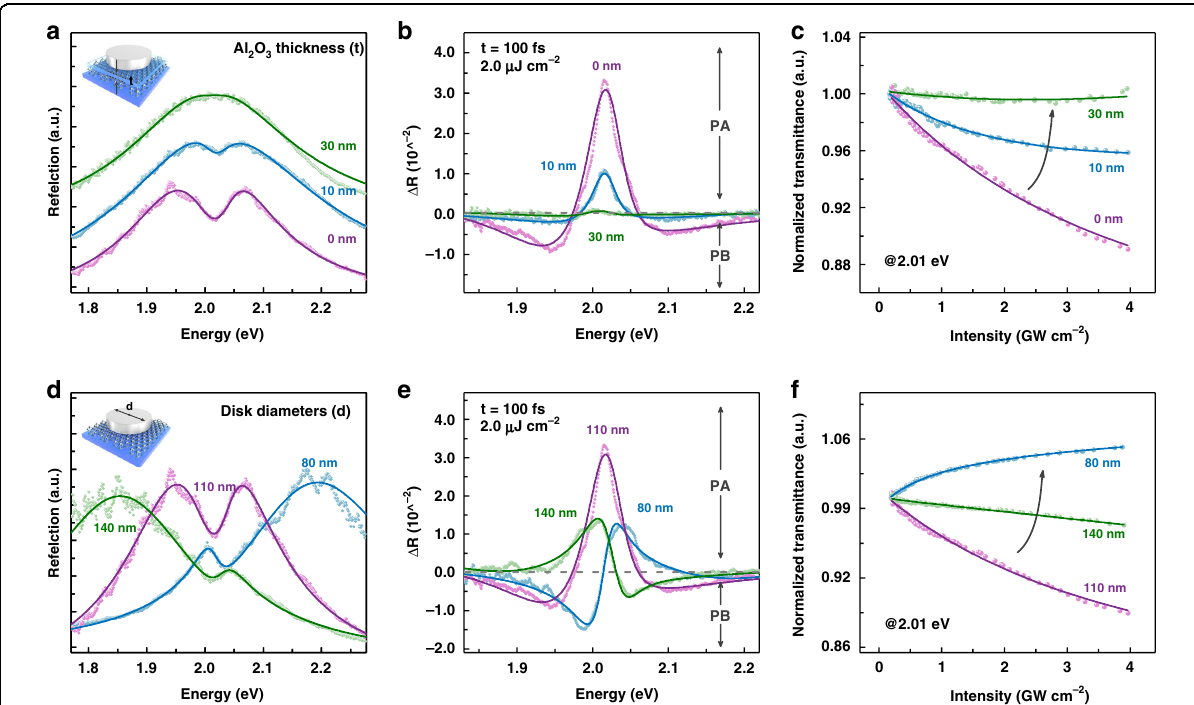
Fig. 4 Tuning plexcitons for controllable ultrafast NLA. a Re fl ection spectra, b differential re fl ection spectra, and ( c ) NLA experimental results of Ag ND – WS 2 samples with different Al 2 O 3 thicknesses. The dielectric interlayer Al 2 O 3 was deposited on top of the ML WS 2 via the atomic layer deposition technique. d Re fl ection spectra, e differential re fl ection spectra, and f NLA experimental results of Ag ND – WS 2 samples with distinct disk diameters. The NLA experimental results of the bare substrate, Ag NDs, and WS 2 were also measured and are presented in Fig. S22, providing a consistency check of our NLA